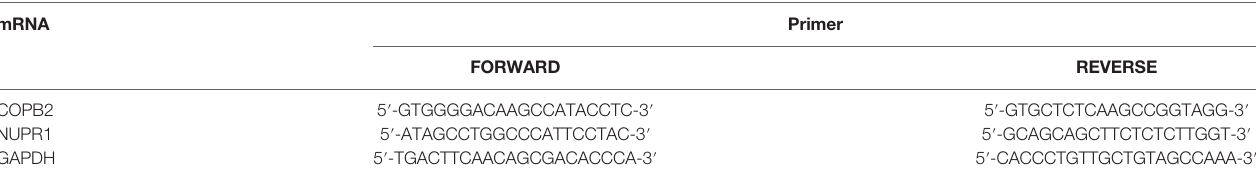
TABLE 2 | Sequences of primers used for